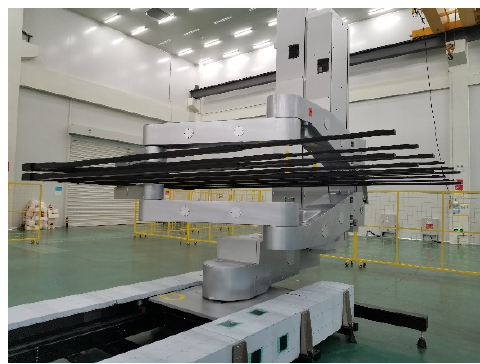
Figure 1. Glass transport robot.